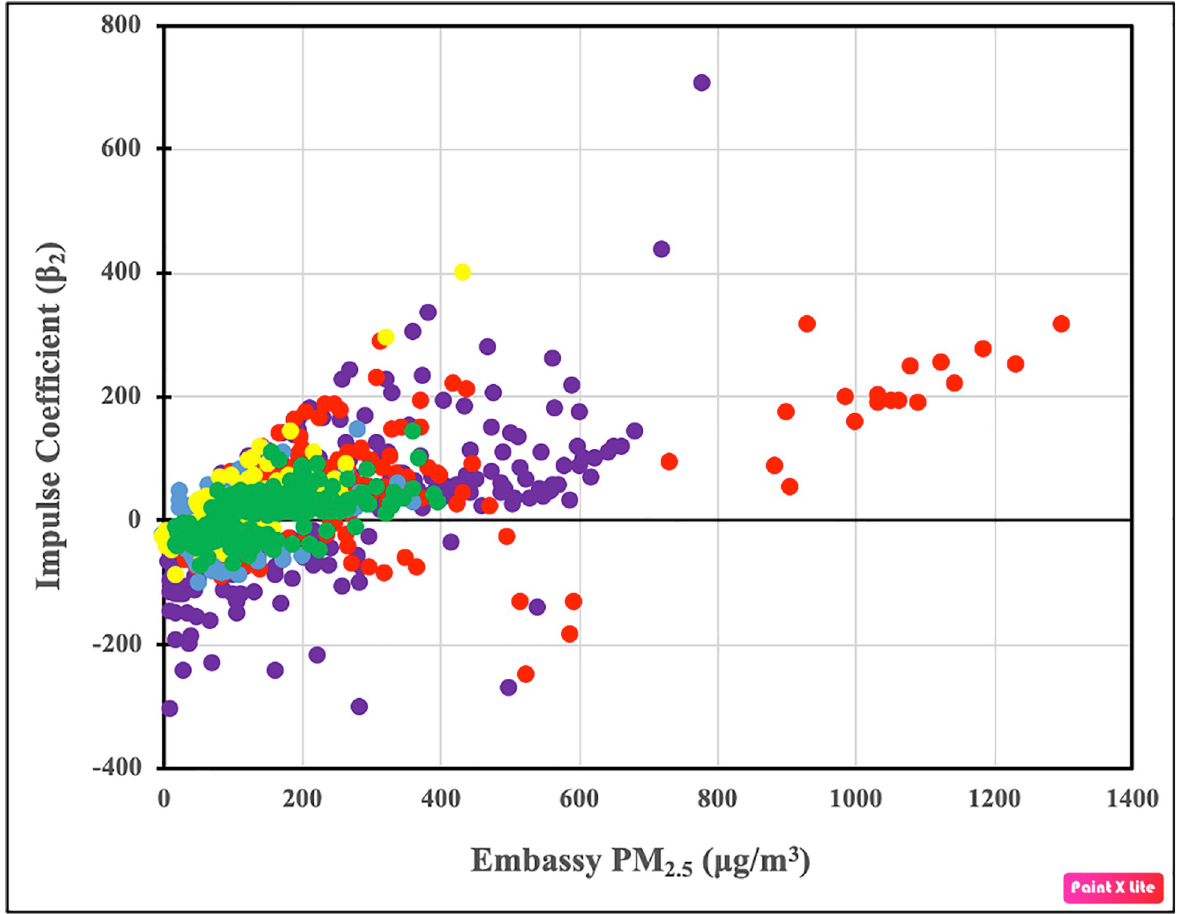
Fig 1. Relation between U.S. embassy-controlled PM 2.5 concentrations and significant impulses. The coefficient values of all significant impulses were estimated using Eq (2) for Beijing (purple), Shenyang (red), Shanghai (blue), Guangzhou (yellow), and Chengdu (green). Statistical information about these relations is given in Table 3.